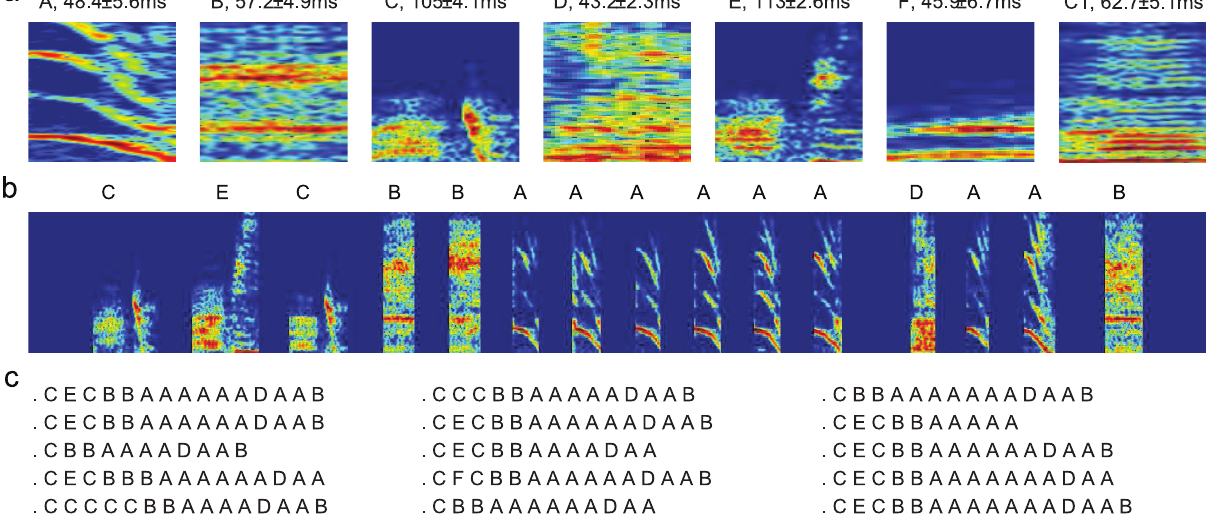
Figure 8. The syllables and song sequences (Bird 2). The convention is the same as in Figure 1.